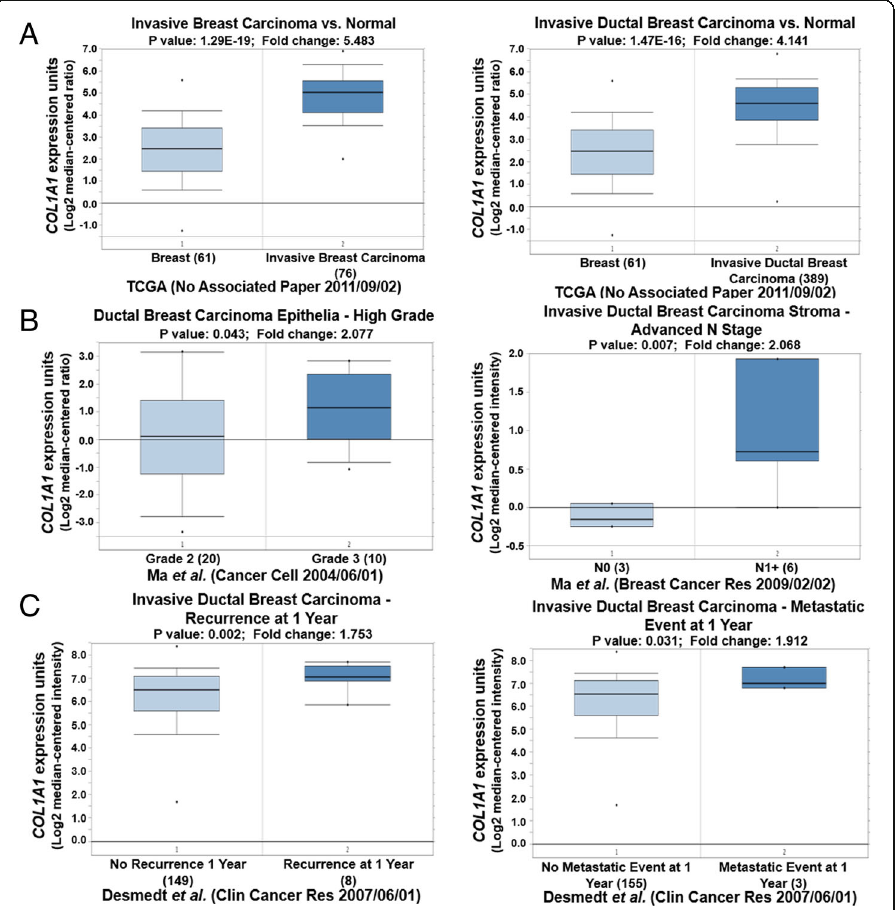
Fig. 4 Validation of COL1A1 expression in breast cancer using Oncomine datasets. a – High